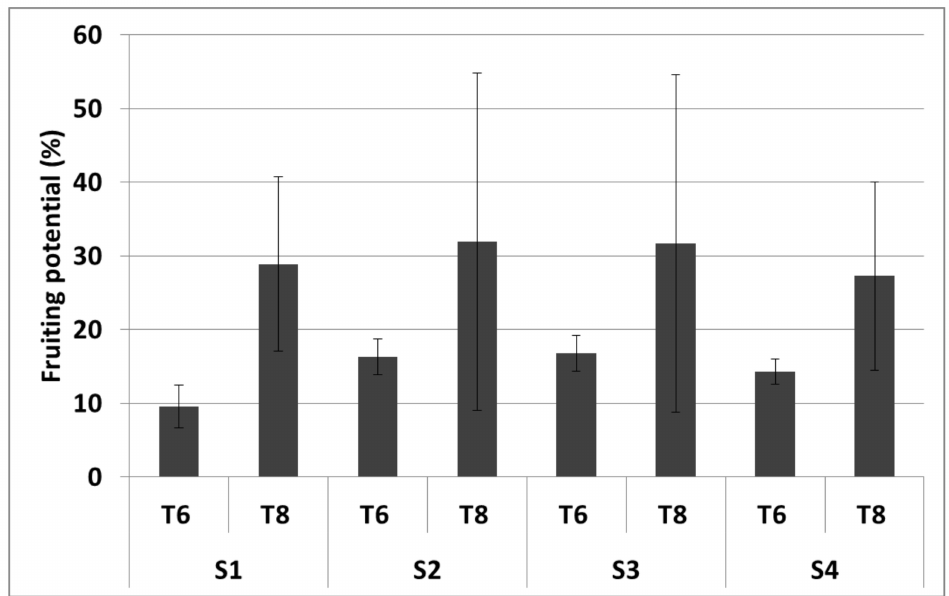
Figure 9. Evolution at T6 and T8 of the fruiting potential in % (percentage of flowers, wilted flowers, fruits on the total of buds) considering only growing substrates (S1: 100% coconut fiber; S2: 66% coconut